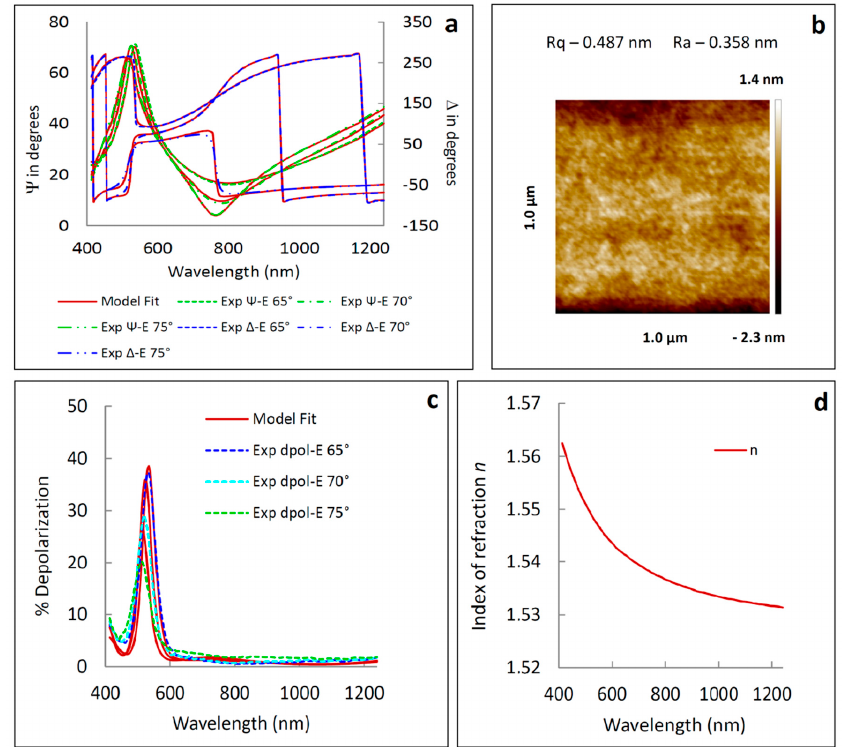
Figure 14. ( a , c ) The measured and calculated Ψ and ∆ azimuths and depolarization factor %Depol for Si/SiO 2 /PVP No.2 (Table 3). The value of χ 2 =10.6. ( b ) The AFM image of Si/SiO 2 /PVP no. 2 (Table 3). ( d ) The refractive index ( n ) of the PVP film.